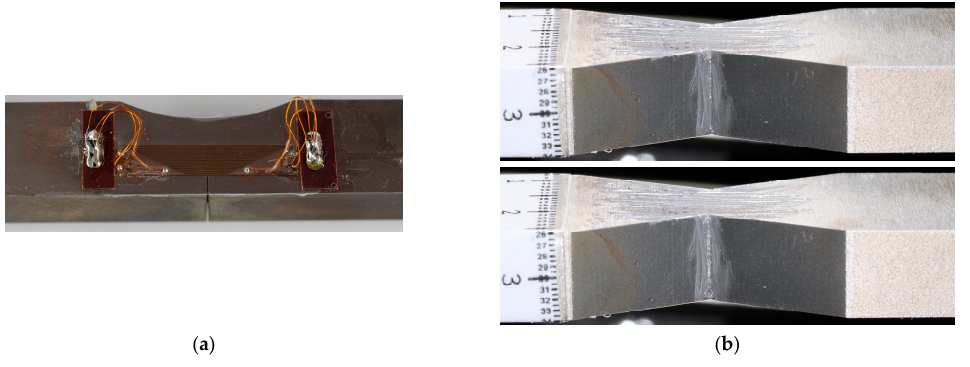
Figure 5. ( a ) Specimen with attached crack gauge after removal of weld overfill and wire erosion of notch into the middle of the weld metal and ( b ) two consecutive pictures of crack detection with photographs (specimen from test series 22).